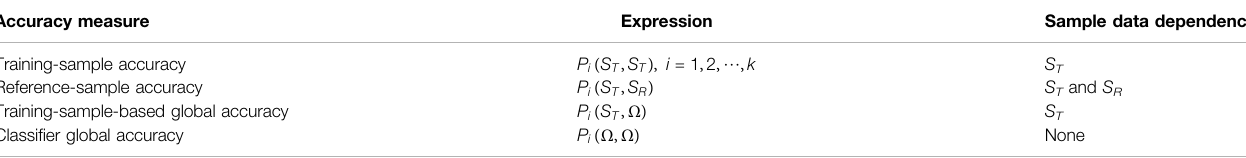
TABLE 3 | Measures of land-use/land-cover classi fi cation accuracy and their data dependencies. Accuracy